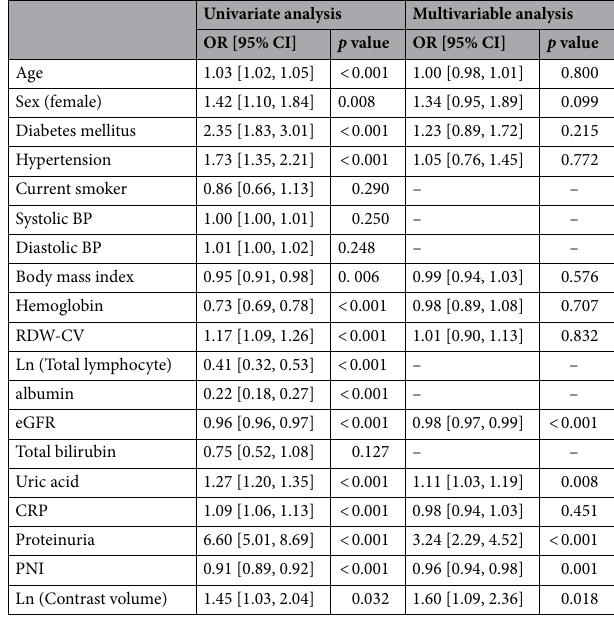
Table 2. Factor related to the development of contrast associated acute kidney injury. OR odds ratio, CI confidence interval, BP blood pressure, RDW-CV red cell distribution width coefficient of variation, eGFR estimated glomerular filtration rate, CRP C-reactive protein, PNI prognostic nutritional index.